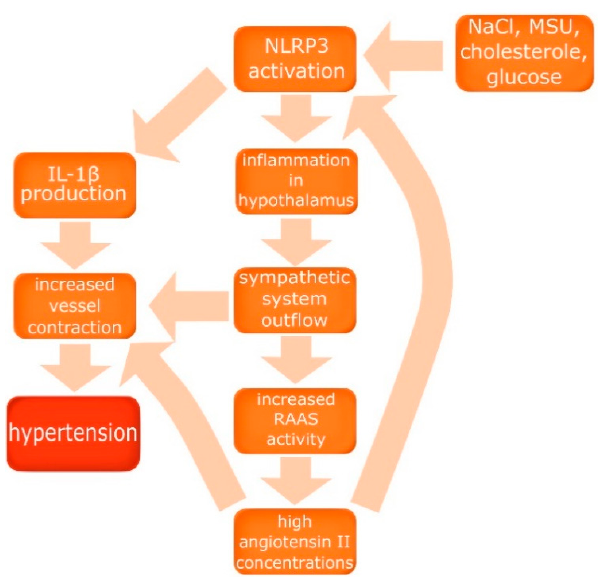
Figure 2. The role of NLRP3 inflammasome in the development of hypertension. Activation of NLRP3 by NaCl, monosodium urate (MSU), or cholesterol induces inflammation in the hypothalamus, leading to sympathetic system outflow, which results in the activation of renin–angiotensin–aldosterone system (RAAS), and angiotensin II leads to further induction of inflammation and NLRP3 activation. IL-1 β has a direct impact on